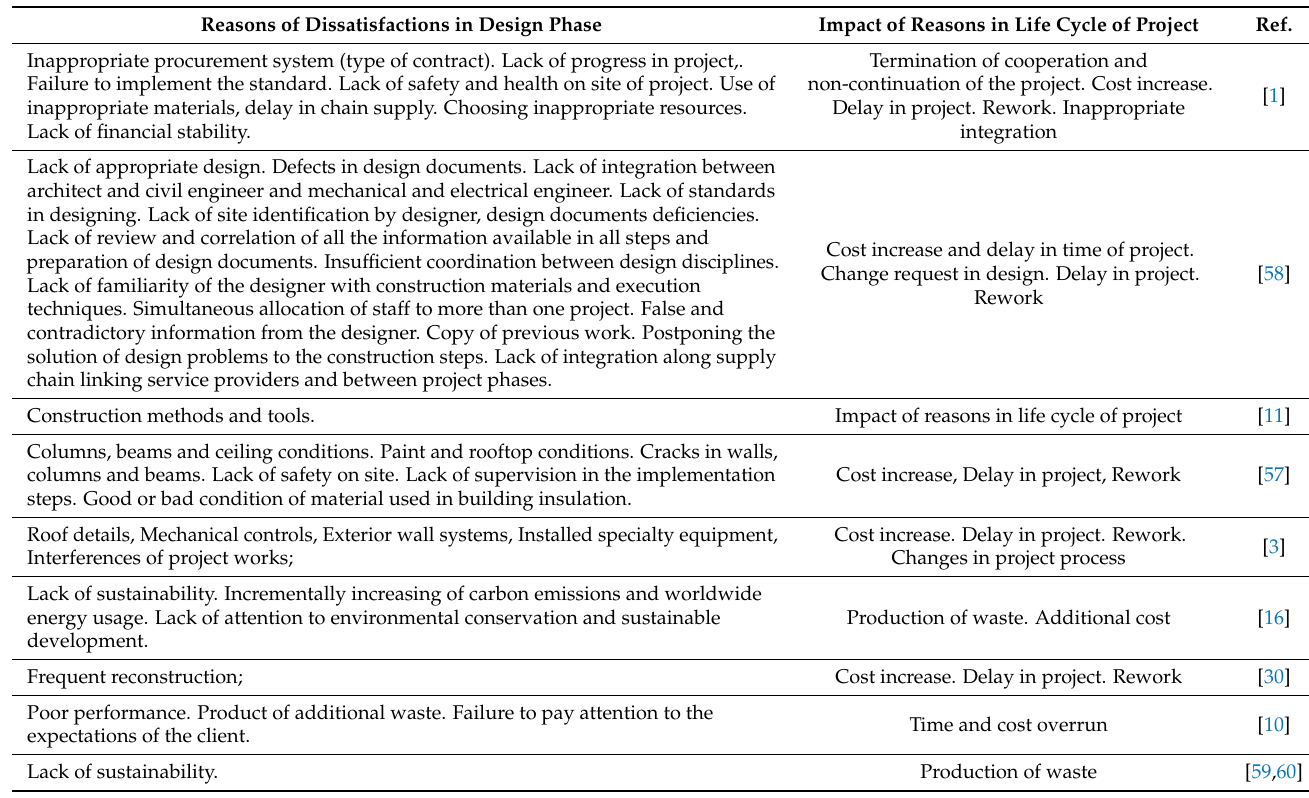
Table 2. Reasons of clients’ dissatisfaction in housing project design and build